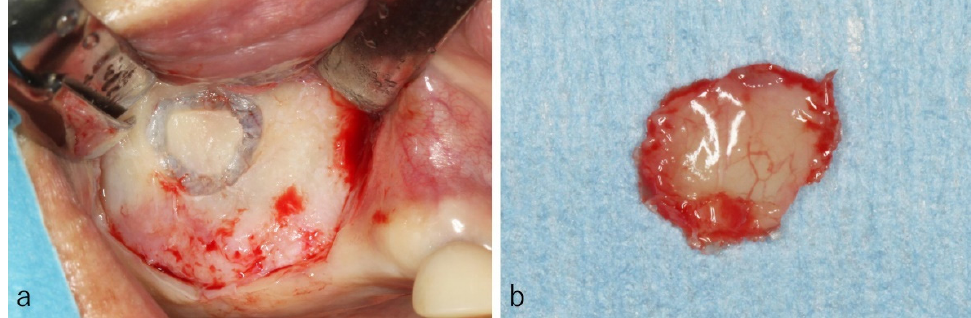
Figure 3. Case: 61 years old male. The osteotomy was performed at the frontal wall ( a ) and the bone segment was removed along with maxillary sinus membrane ( b ).